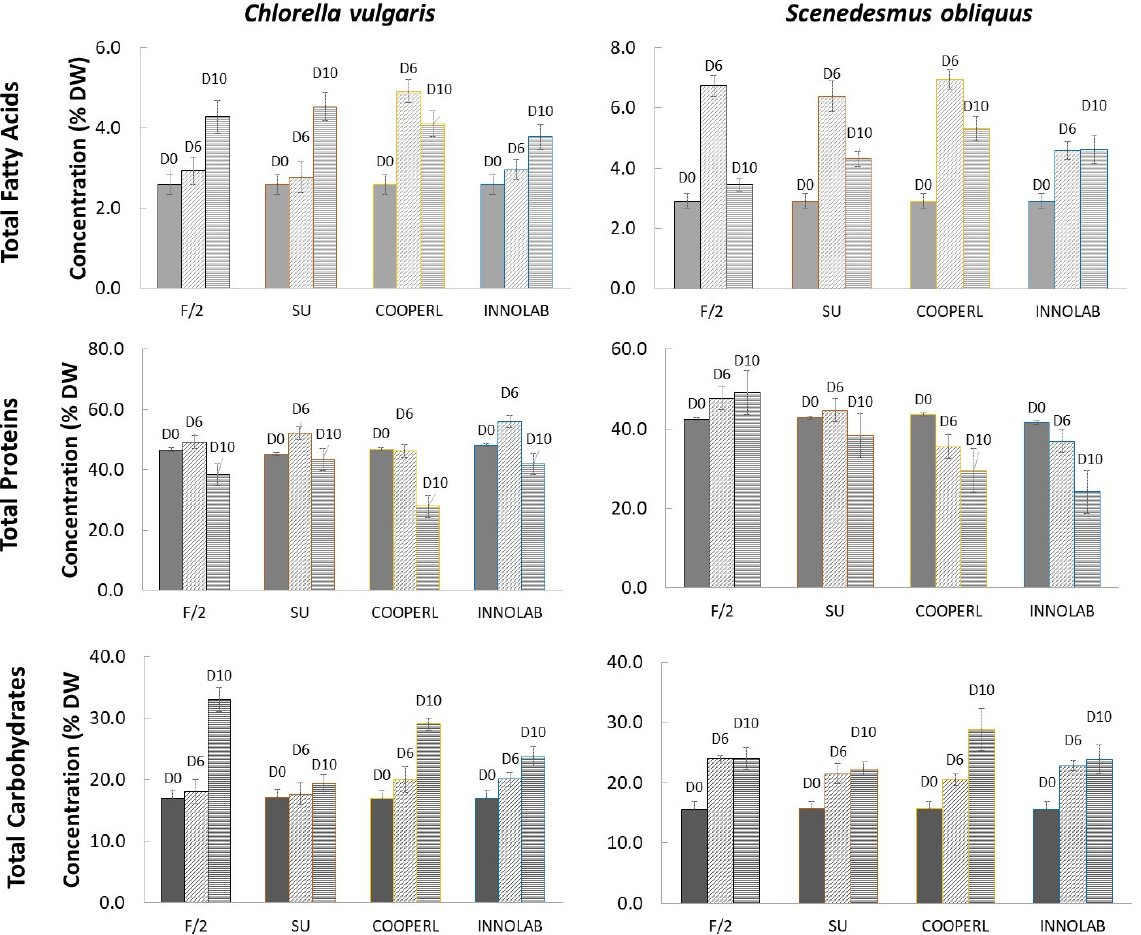
Figure 5. Total fatty acids, proteins, and carbohydrates content in cultures of C. vulgaris and S. obliquus grown on three different digestates under pH manipulation on day 0, 6, and 10 of the experiment. Error bars represent the standard deviation on three replicates.